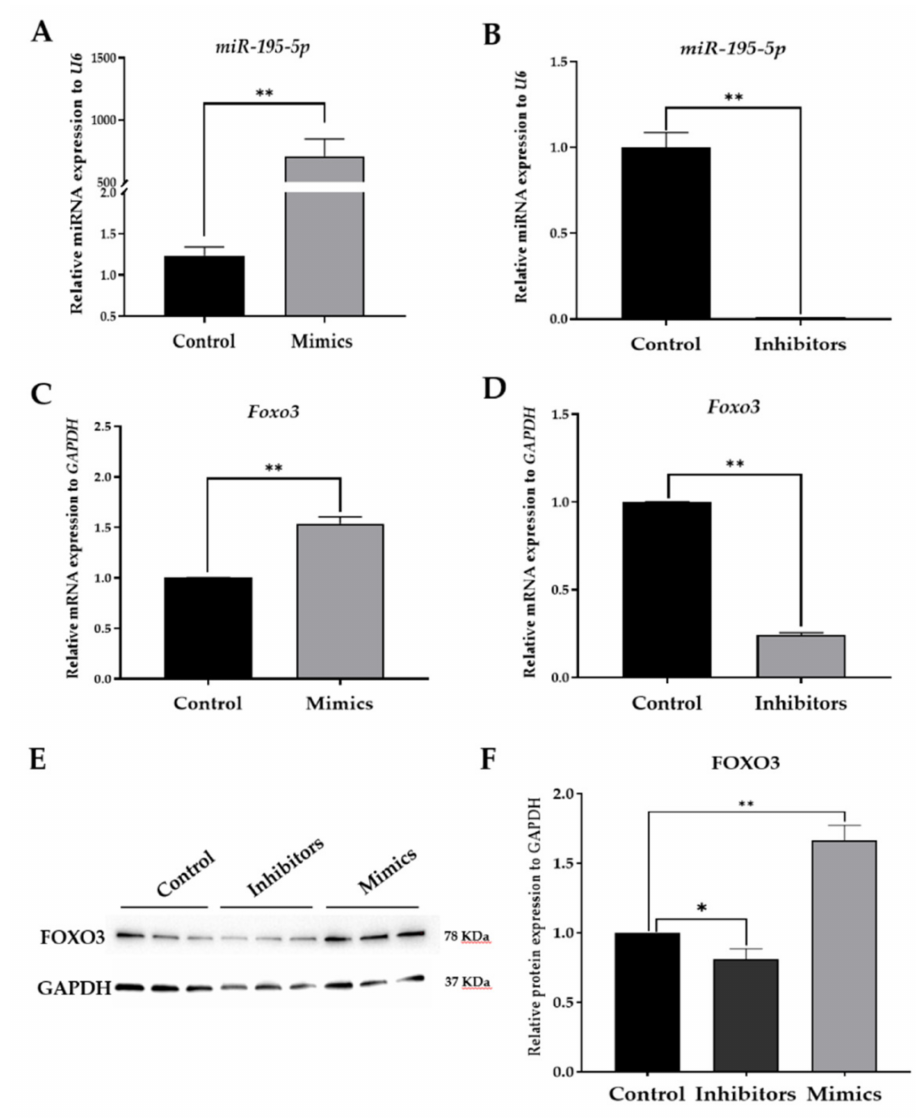
Figure 3. miR-195-5p promotes transcription of Foxo3 in CPIGCs. ( A , B ) RT-qPCR showing the transfection efficiency of miR-195-5p mimics and inhibitors transfected into CPIGCs for 24 h. ( C , D ) RT-qPCR indicating the mRNA expression level of Foxo3 in CPIGCs transfected with miR- 195-5p mimics and inhibitors, respectively. ( E , F ) Western blot assay showing the protein expression level of FOXO3 in CPIGCs after transfection with a miRNA negative control, as well as miR-195- 5p inhibitors and mimics, respectively. Data are mean ± SEM of three independent experiments. * indicates p < 0.05, and ** indicates p < 0.01 when compared with